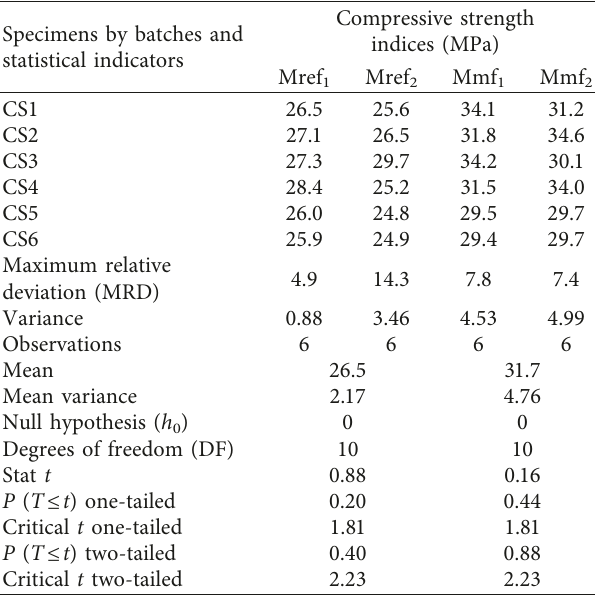
Table 2: Chemical composition of the milled fly sugarcane bagasse ash sample.